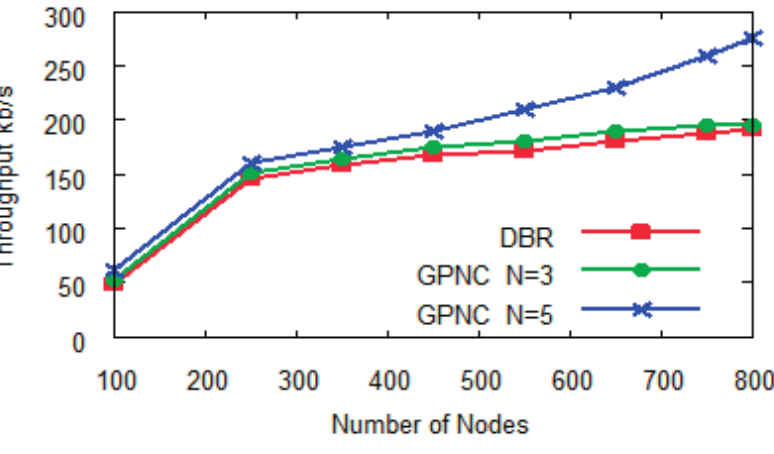
Figure 8. Throughput with number of nodes.